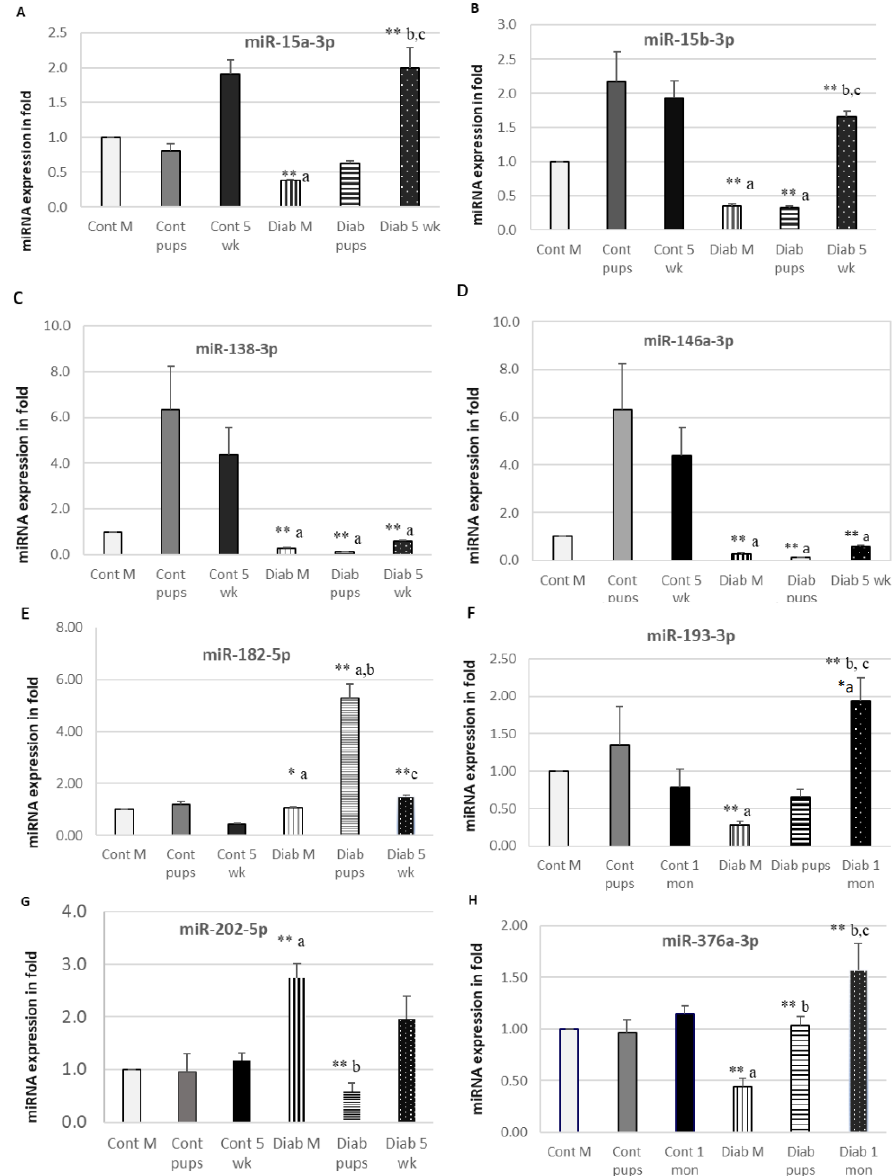
Figure 6. miRNAs expression in brain tissues of control and diabetic mothers and their offspring.